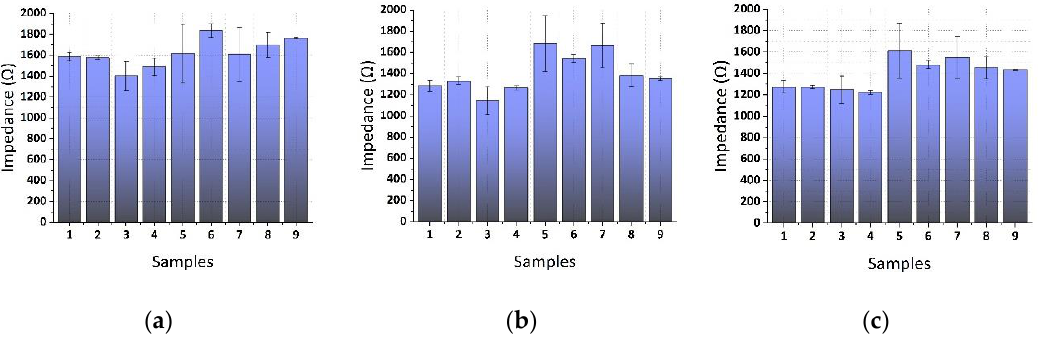
Figure 13. Extracted results from the mean impedance magnitude values for pistachio samples of unknown AFB 1 concentrations tested at ( a ) 1 KHz, ( b ) 10 KHz, and ( c ) 100 KHz.